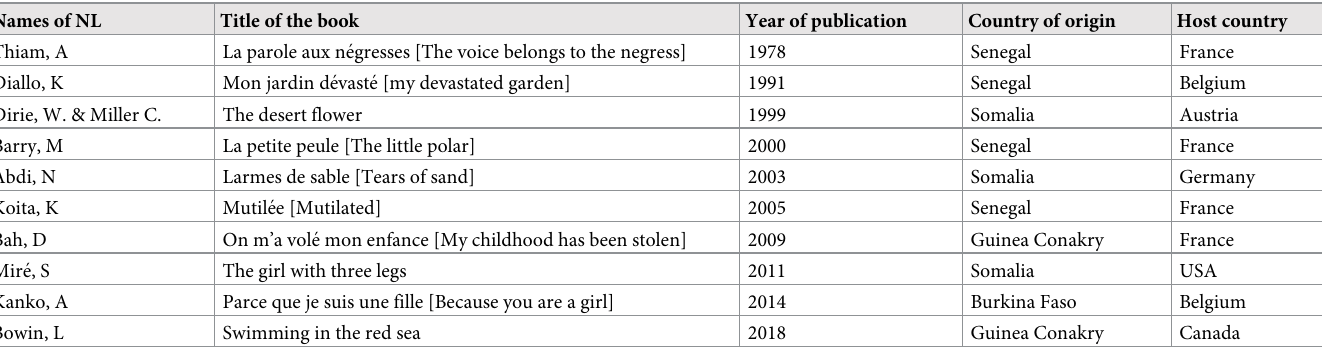
Table 1. Table of the books of norm